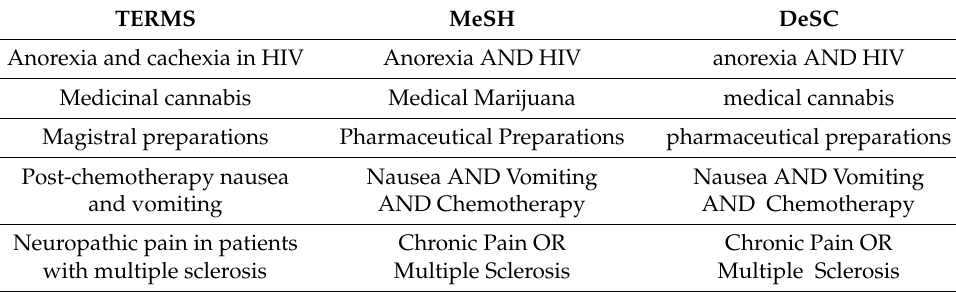
Table 4. MeSH and DeSC used in electronic